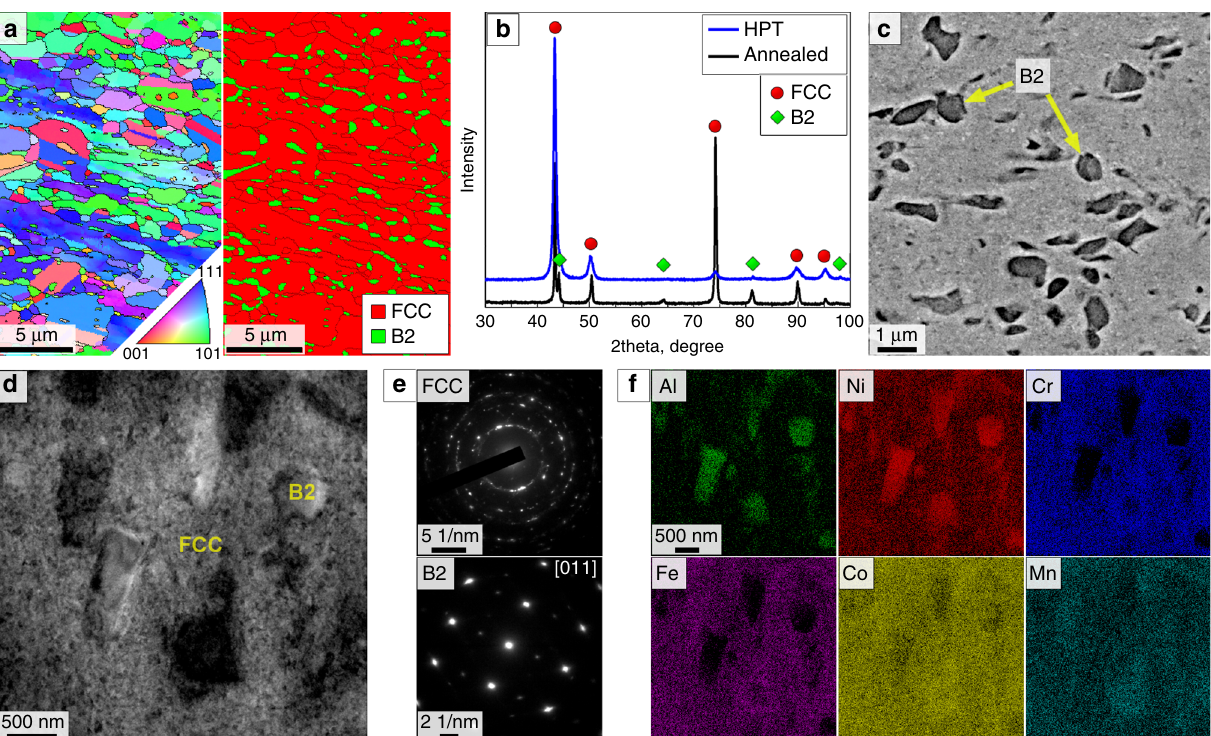
Fig. 1 Initial microstructure before superplasticity tests. a Electron Backscatter Diffraction (EBSD) — Inverse Pole Figure (IPF) map and corresponding phase map of annealed specimen, b X-Ray Diffraction (XRD) patterns of the annealed and High-Pressure Torsion (HPT) processed specimen, c Backscattered Electron (BSE) image of the as-HPT specimen, d Transmission Electron Microscopy (TEM) image of the as-HPT specimen, e Selected Area Electron Diffraction (SAED) patterns of Face-Centered Cubic (FCC) and ordered Body-Centered Cubic (B2) phases, f Transmission Electron Microscopy (TEM) — Energy- Dispersive X-ray Spectroscopy (EDS) maps of the as-HPT specimen showing chemical distribution of the constituent elements.